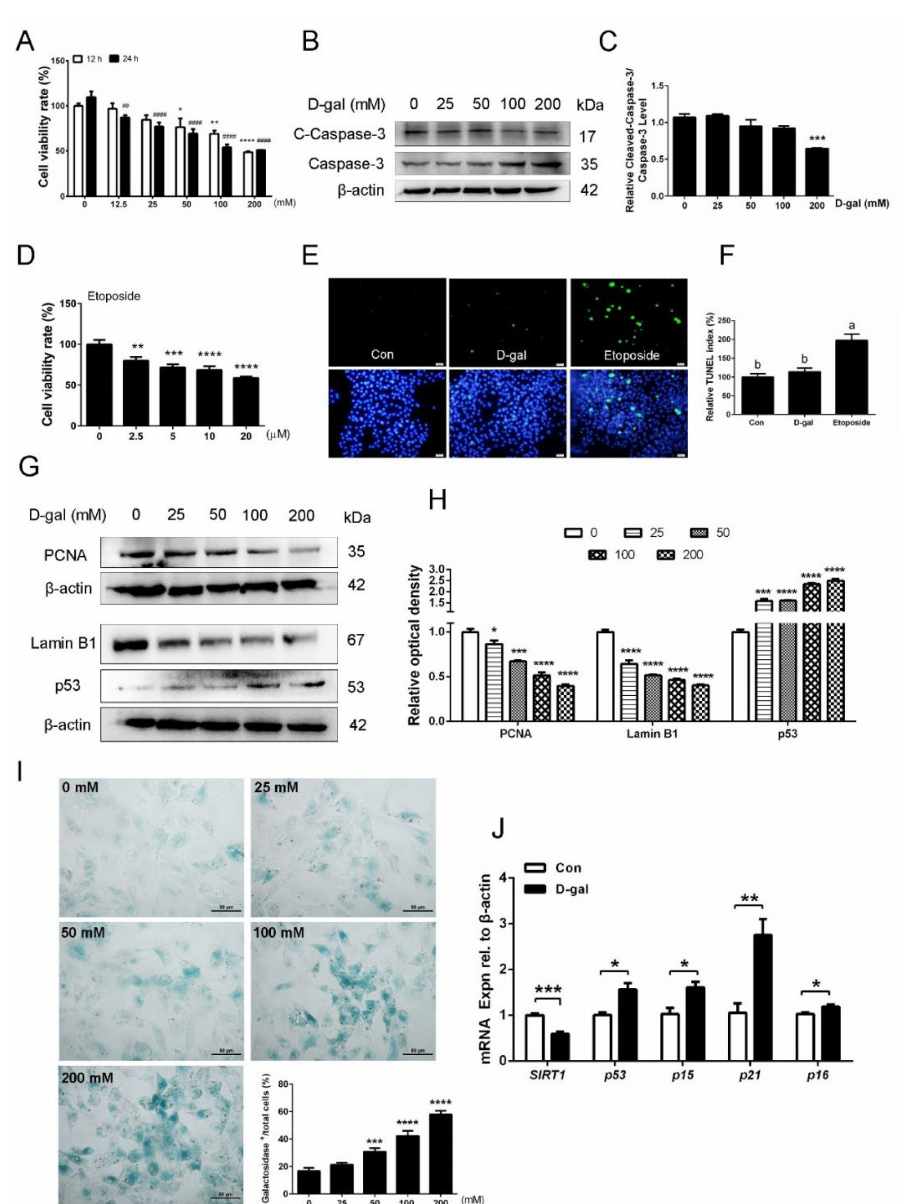
Figure 3. Treatment with D-gal promotes the expression of senescence-associated biomarkers in the SYF-GCs of D280 hens. ( A ) The effect of D-gal on GC cell viability as detected by CCK-8 (n = 6). ( B , C ) Western blot analysis of the expression of c-caspase-3 and caspase-3 in GCs exposed to 0 mM, 25 mM, 50 mM, 100 mM, and 200 mM of D-gal for 24 h. ( D ) GCs were treated with etoposide with a concentration of 0 to 20 µ m for 24 h and cell viability was measured by CCK-8 (n = 6). ( E , F ) TUNEL assay to detect apoptotic GCs in control, D-gal-, and etoposide-treated groups. Scale bar: 20 µ m. Different lowercase letters indicate significant differences ( p < 0.05). ( G , H ) Protein levels of PCNA, Lamin B1, and p53 in GCs treated with a gradual increase in the concentration of D-gal. ( I ) Representative images showing β -galactosidase staining in GCs treated with D-gal at 0 mM, 25 mM, 50 mM, 100 mM, and 200 mM concentrations for 24 h. Scale bar: 50 µ m. ( J ) qPCR analysis of SIRT1 , p53 , p15 , p21, and p16 mRNA levels in control and D-gal-treated GCs. * p < 0.05, ** p < 0.01, *** p < 0.001, **** p < 0.0001 which represent the difference between the groups in which the GCs were treated with D-gal of different concentrations for 12 h compared to the control. # Indicates the difference between 24 h and the